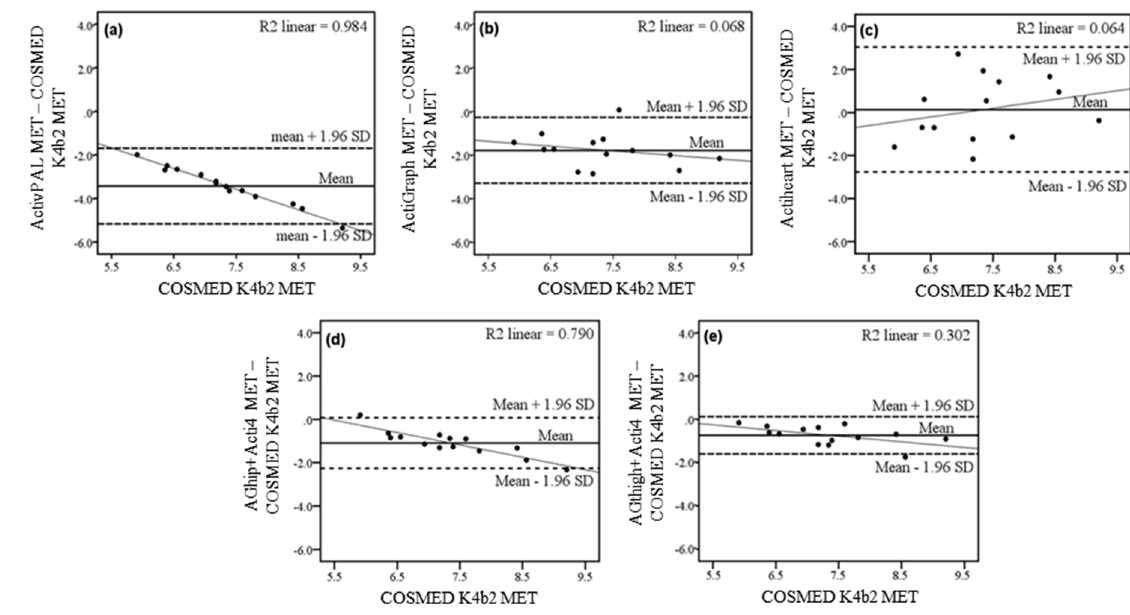
Figure 3. Bland-Altman plots of the EE estimated in the physical activity types walking, running, cycling and walking stairs in the semi-standardized protocol of the methods: ( a ) ActivPAL; ( b ) ActiGraph; ( c ) Actiheart; ( d ) AGhip + Acti4 and ( e ): AGthigh + Acti4. Dashed lines represent the limits of agreement (±1.96 SD), solid line represents the mean difference between estimated and measured EE. The thin line represents the linear regression between EE by COSMED and difference between EE estimated by different methods and COSMED. R 2 is the Pearson coefficient of determination of individual scatter plots to this linear regression